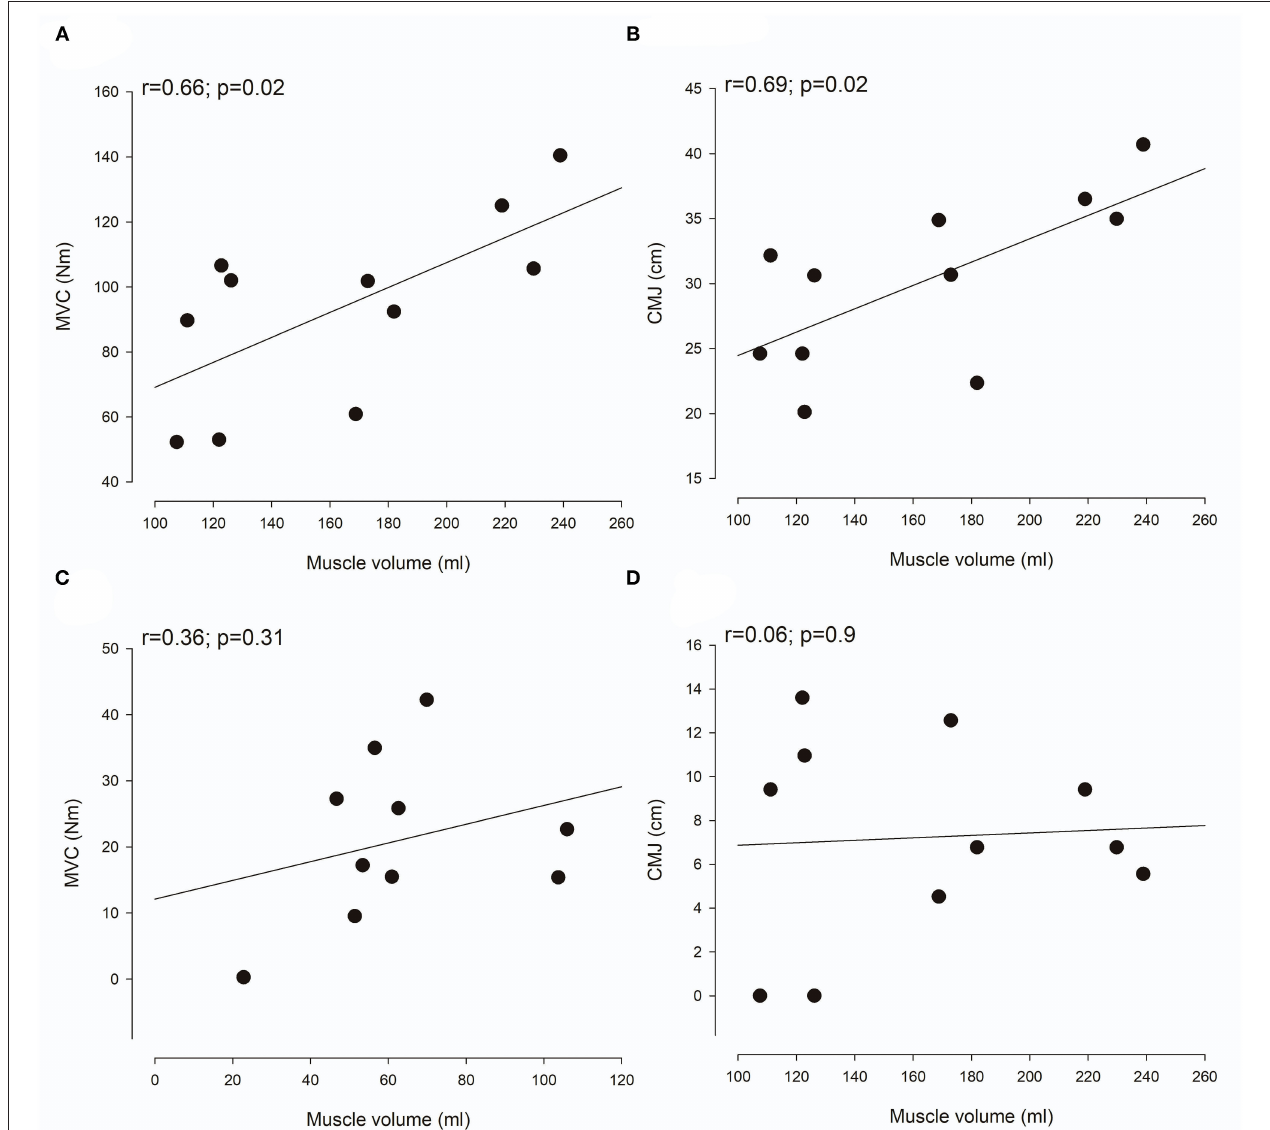
FIGURE 3 | Relationship between muscle volume and function. (A,C) show the correlation between muscle volume of the medial gastrocnemius muscle and maximal voluntary contraction (MVC) in neurologically intact (NI) adults (A) and adults with Cerebral palsy (CP) (C) . (B,D) show the correlation between muscle volume of the medial gastrocnemius muscle and countermovement jump (CMJ) in NI adults (B) and adults with CP (D) . Each plot shows the trend line as well as individual data